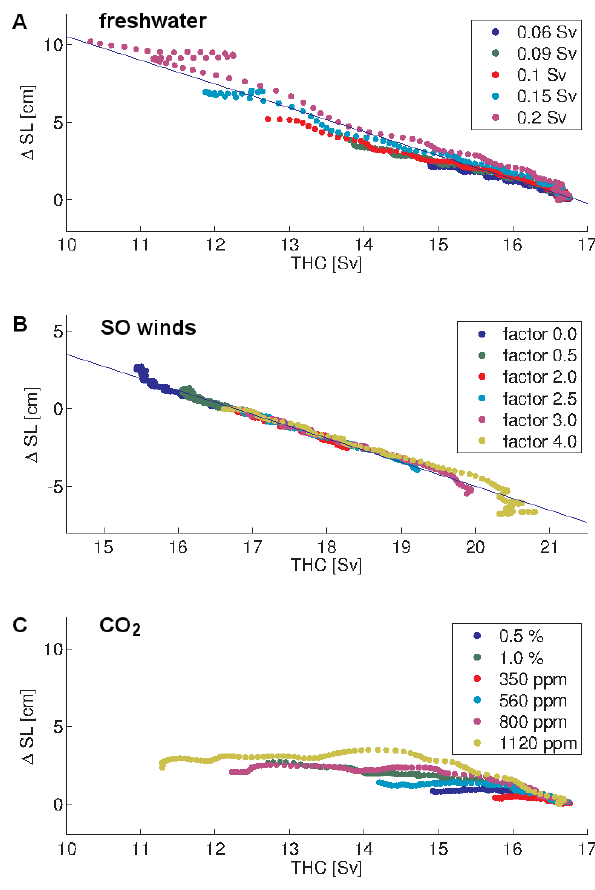
Fig. 3. 1 SL between North and Central for the following forcings: Fig. 3. ∆ SL between North and Central for the following forcings: (A) freshwater (slope: (cid:0) 1.53 cm Sv (cid:0) 1 ), (A) freshwater (slope: − 1.53cmSv − 1 ), (B) Southern Ocean winds (B) Southern Ocean winds (slope: (cid:0) 1.54 cm Sv (cid:0) 1 ), (C) CO 2 . (slope: − 1.54cmSv − 1 ), (C) CO 2